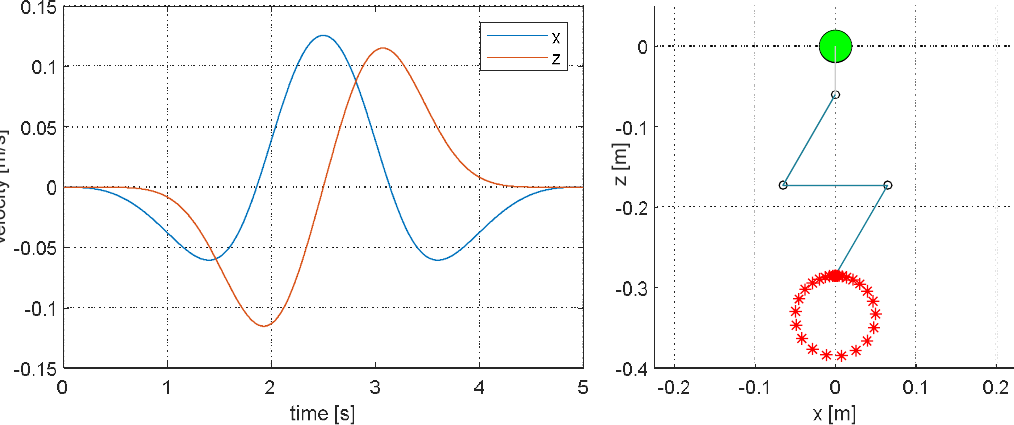
Figure 4. End-effector desired velocities for the circular trajectory ( left ) and initial configuration for a 3-DOF manipulator ( right ). The UAV base is the large green marker, joints are the black circles, links are the blue lines, and end-effector positions tracked are the red crosses.